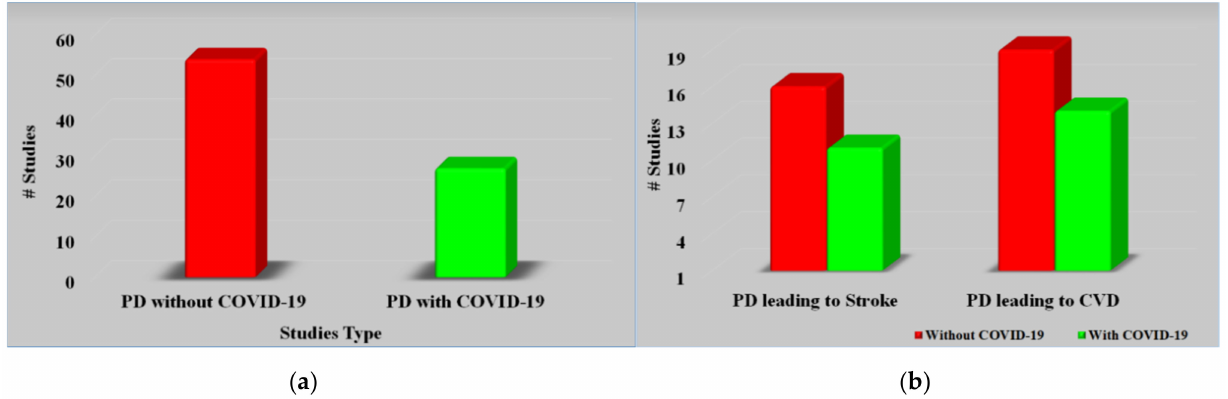
Figure 2. ( a ) Studies related to PD with or without COVID-19. ( b ) Studies related to PD leading to stroke and CVD with or without